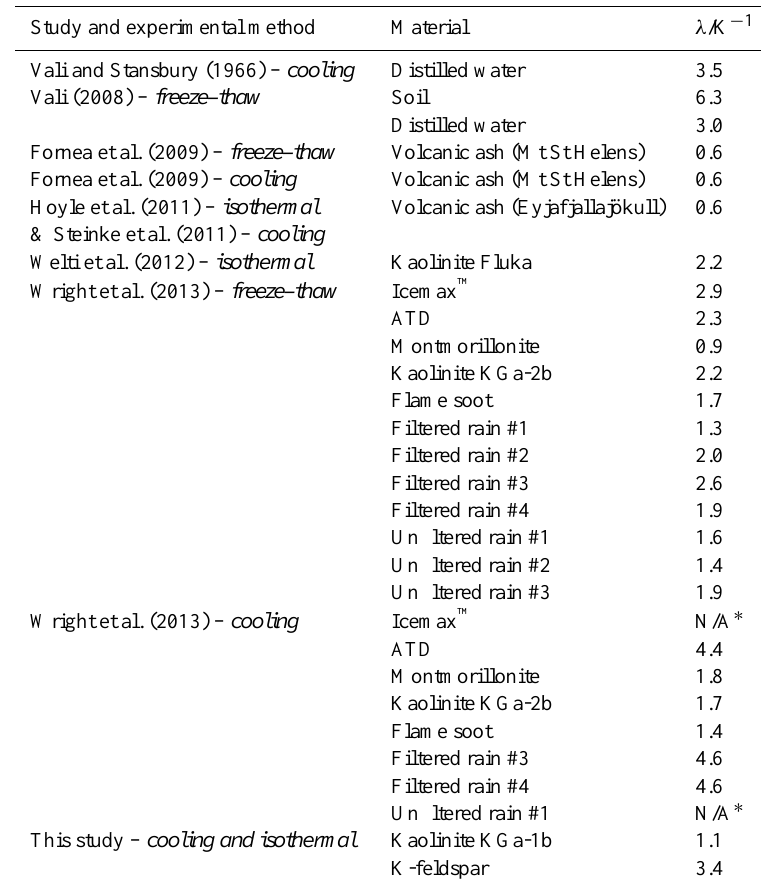
Table 2. Summary of λ values from various immersion mode studies determined using the FROST